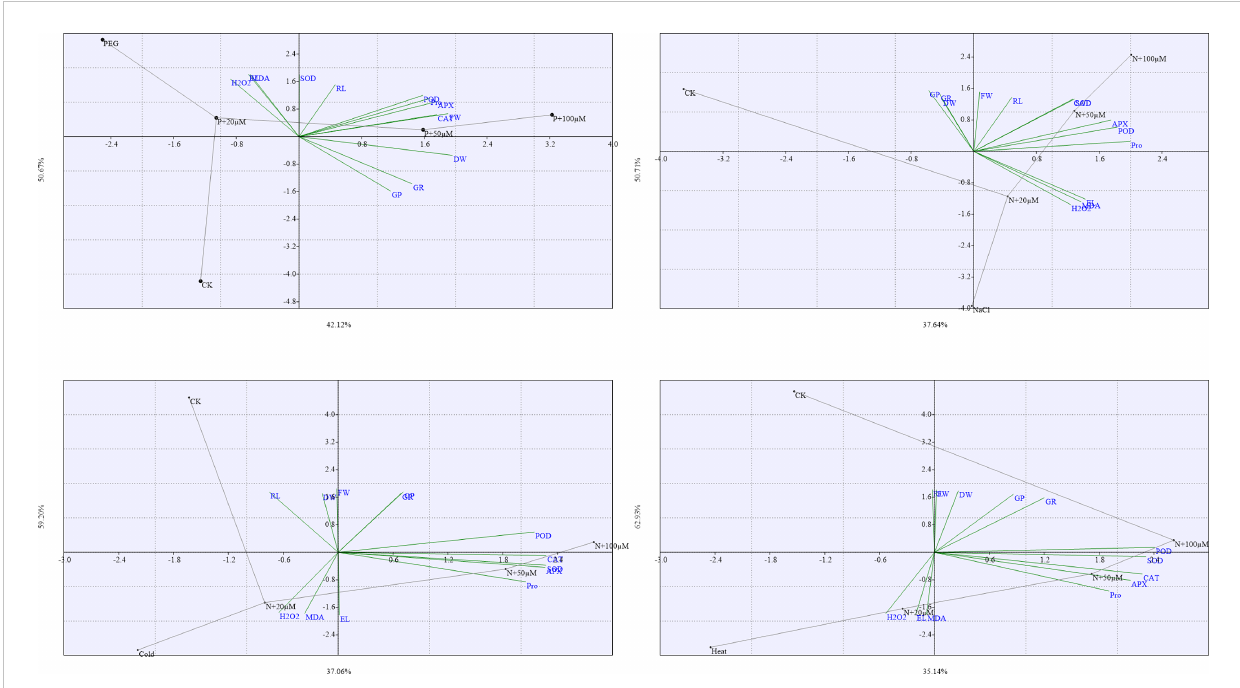
FIGURE 10 The Loading plots of principal component analysis (PCA) of different measured parameters of soybean seed germination at different concentrations of melatonin under drought (A) , salt (B) , cold (C) , and heat (D) stress. The abbreviations used in the plots are as follows; germination potential (GP), germination rate (GR), fresh weight (FW), dresh weight (DW), proline (Pro), electrolyte leakage (EL), malondialdehyde (MDA), hydrogen peroxide (H 2 O 2 ) superoxide dismutase (SOD), catalase (CAT), peroxidase (POD), and ascorbate peroxidase (APX). Here, µM is indicating (µmole L -1